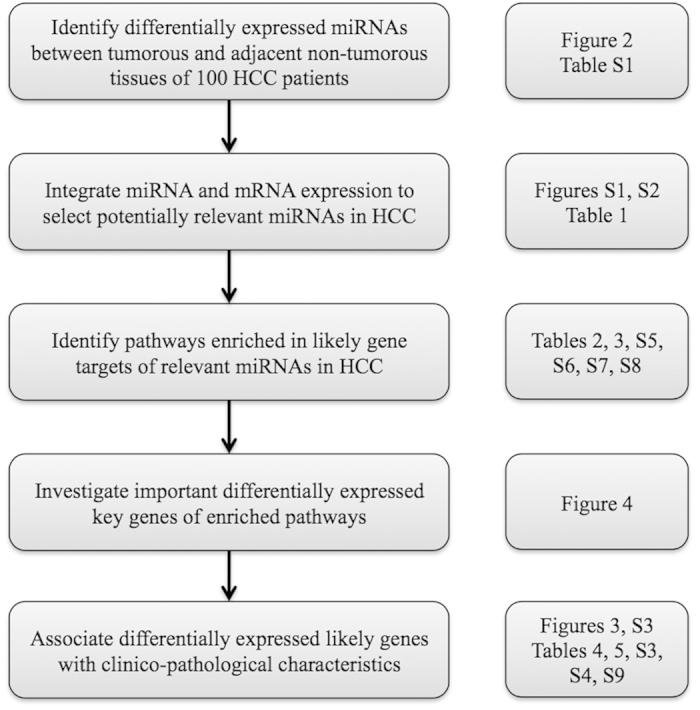
Schematic overview of the workflow implemented for identification of differentially expressed regulatory miRNAs and their targets in HCC.